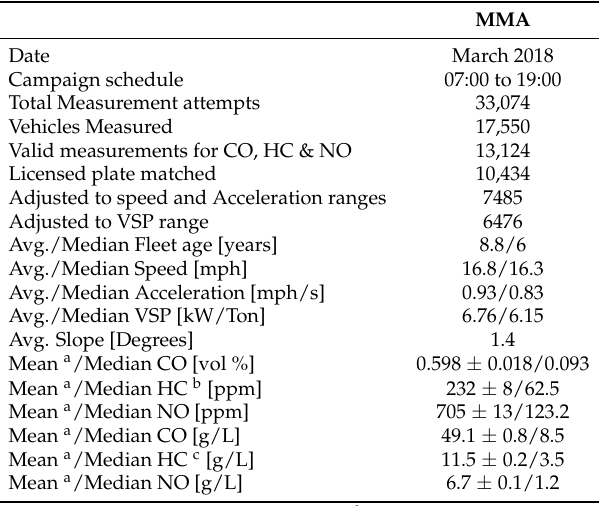
Table 2. Overall results of the MMA RSD